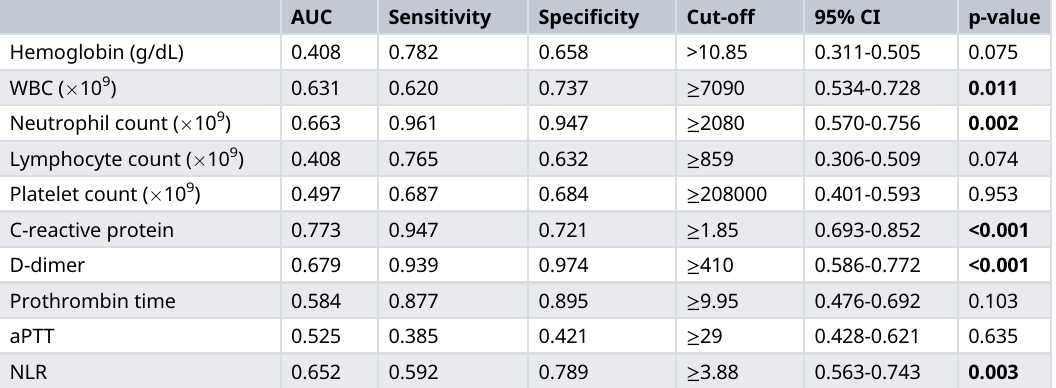
Table 3. Sensitivity and specificity of laboratory